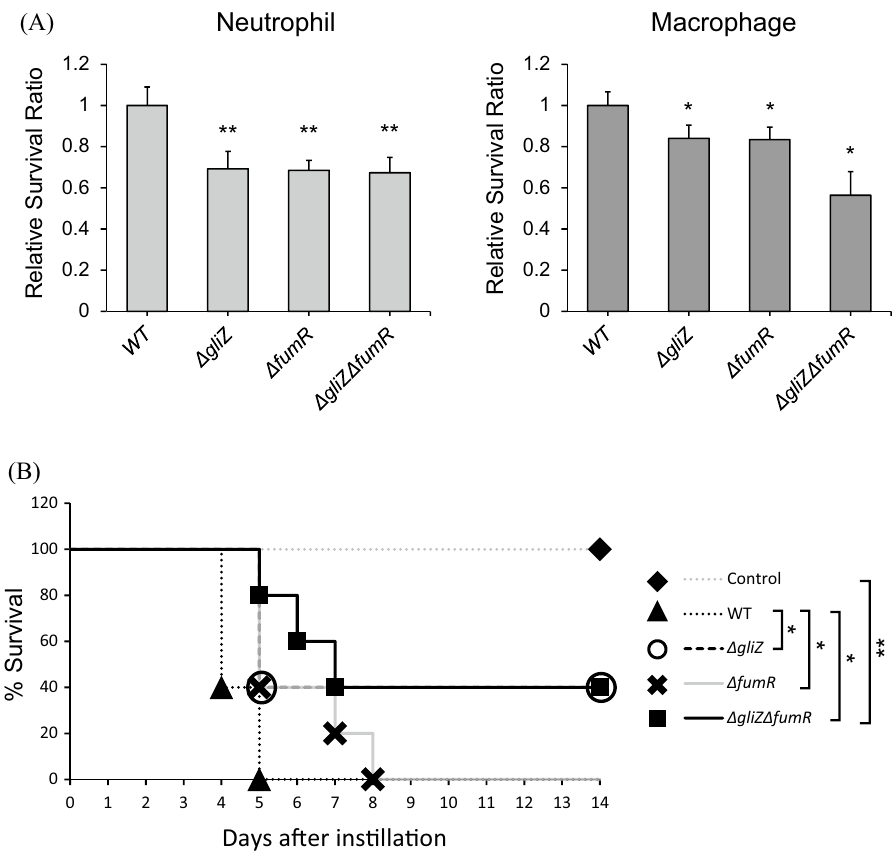
Figure 6. Gliotoxin and pseurotin A biosynthesis are the virulence factors. ( A ) A conidial killing assay with HL-60 differentiated macrophages and neutrophils was performed. A total of 1 × 10 6 conidia of the indicated strains were added for 1 h, and the infected cells were washed with 1× PBS and harvested with 1× PBS. The cells were resuspended in 100 µl of 1× PBS and lysed, and then, the cell lysates were incubated on AMM. The left panel and right panel indicate neutrophils and macrophages, respectively. The graph shows the relative number of fungal colonies grown on AMM compared to that of the wild-type cells. * p < 0.05 and ** p < 0.01 indicate a significant difference compared to the control group. ( B ) A virulence test was performed with a murine model, and 5 × 10 5 conidia of the indicated strains were used to infect mice. The mice were anesthetized with isoflurane, and 5 × 10 5 spores (50 µl) were nasally infected per mouse. The number of mice used in each experimental group was five, and all mice were six weeks old. P = 0.0078. Curves were plotted and p-values were calculated by using GraphPad Prism software. * p < 0.05 and ** p < 0.01 indicate a significant difference compared to the control